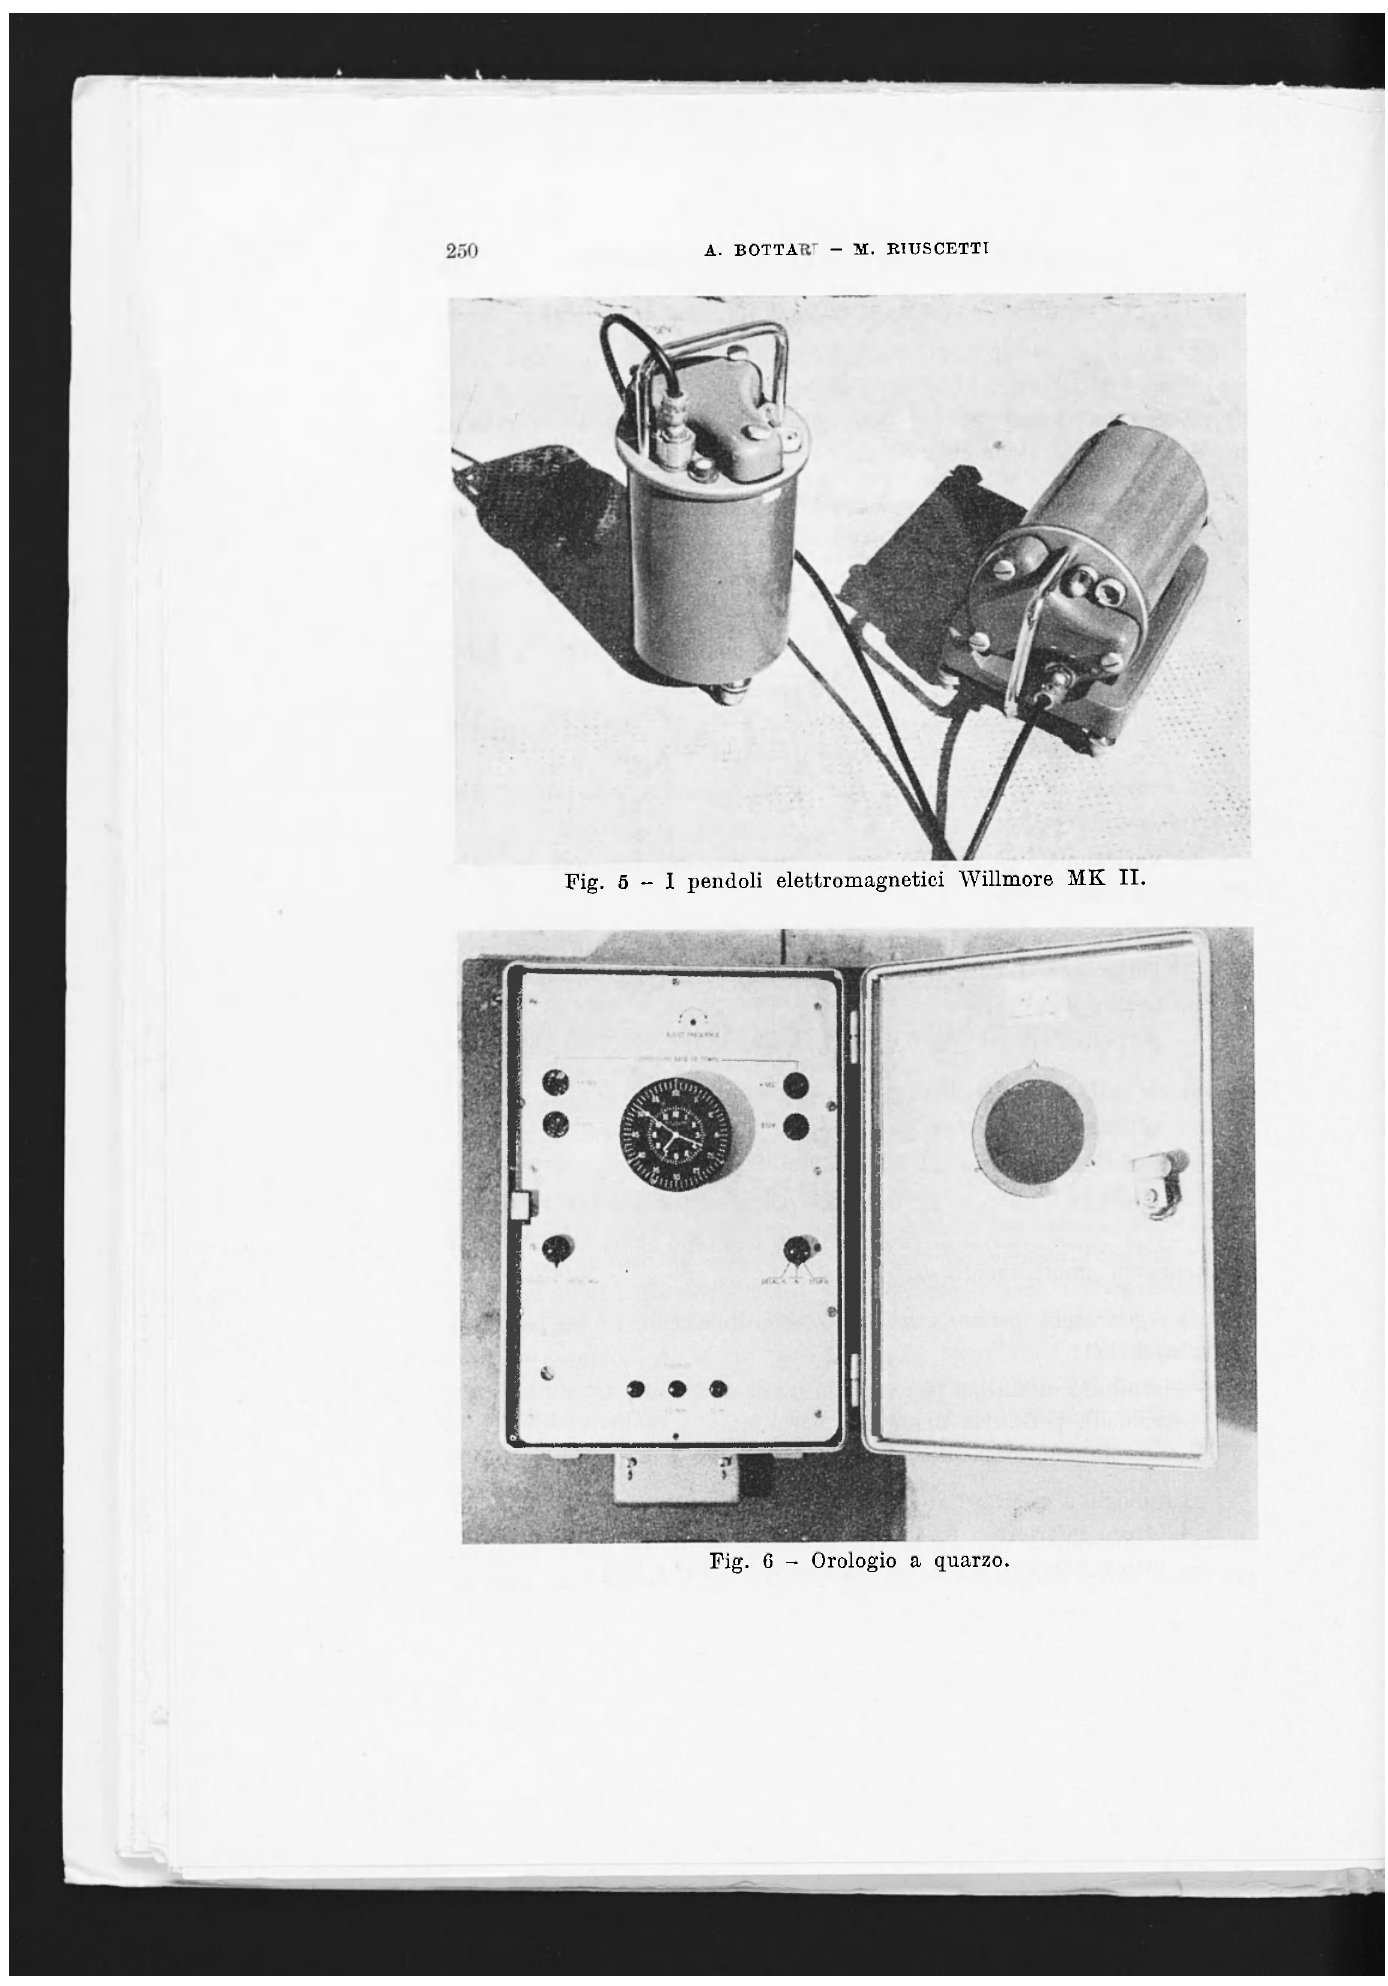
Fig. 6 - Orologio a